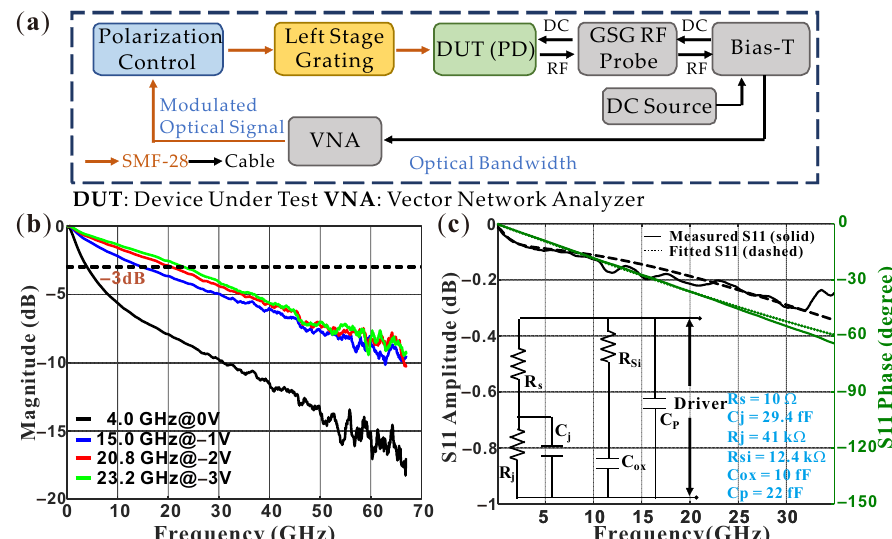
Figure 8. ( a ) Experiment setup for the OE bandwidth measurement. ( b ) The frequency response of MM-PD. The 3 dB opto-electrical bandwidth reaches 23 GHz at − 3 V bias. ( c ) Fitting of the real (black line) and imaginary (green line) of the measured PD S11 parameter at − 3 V according to the equivalent small signal circuit model in the inset. In the model, R j is the junction resistance, C j is the junction capacitance, R s is the series resistance, C p is the parasitic capacitance between the electrodes, C ox is the buried layer capacitance, and R si is the substrate contact